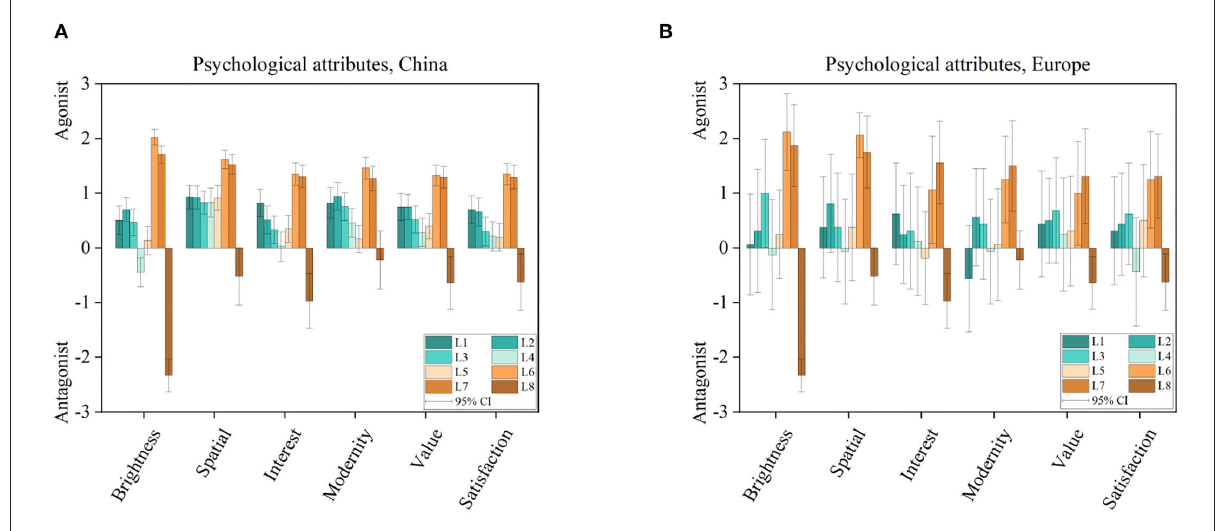
FIGURE5 Six psychological attributes rated on a semantic scale from 3 as highly supporting to − 3 as highly contradiction associated with eight illumination settings L1–L8, compare Table 2, evaluated in the Chinese (A) and European (B) group.